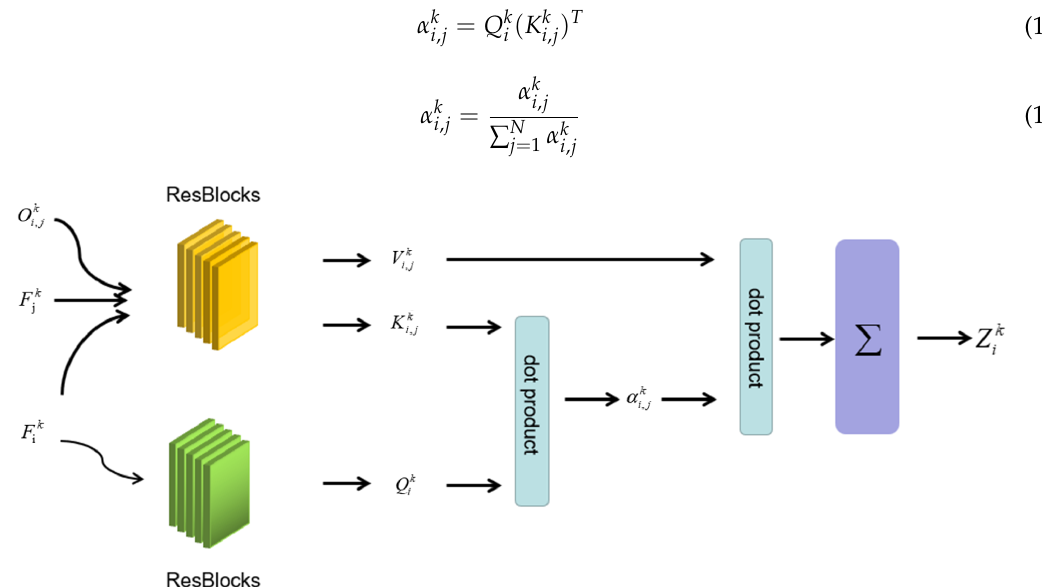
Figure 4. The structure of Attention Based Spatial Fusion Network